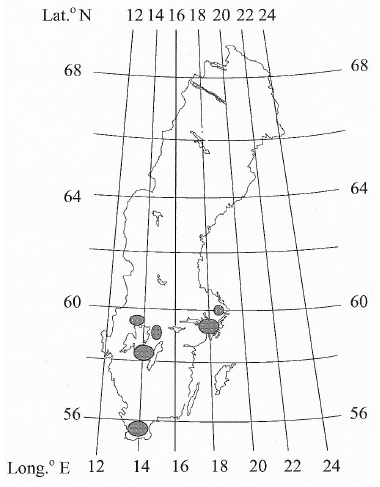
Figure 1. Locations of the sampled hybrid larch trees growing on former farmland in